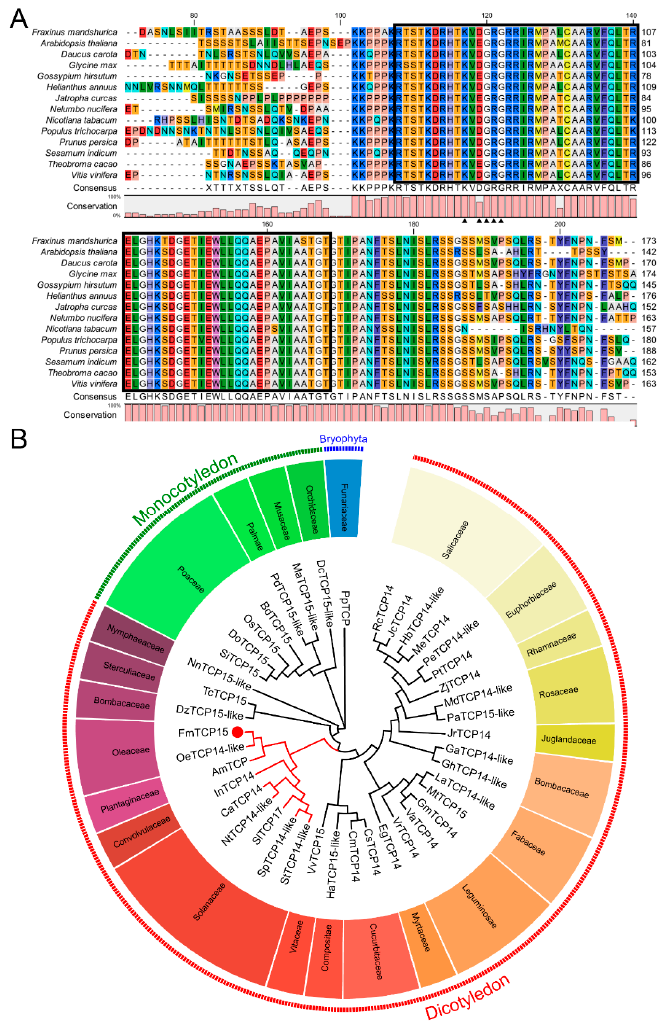
Figure 2. Multiple sequence alignment and phylogenetic relationship of FmTCP15 protein. ( A ) Homolog alignment of FmTCP15 protein. The colored bars at the bottom represent the conservation percentage. The black box and black triangle represent the TCP conserved domain and five ligand binding sites, respectively. ( B ) Phylogenetic relationship of FmTCP15 proteins. The phylogram of FmTCP15 proteins is presented in circle mode (displays only topology). The phylogenetic tree was constructed using the neighbor-joining method with MEGA 5.0 software (Oxford University Press: New York, NY, USA). FmTCP15 is denoted by a red dot. FmTCP15 ( Fraxinus mandshurica ), DzTCP15-like ( Durio zibethinus ), HaTCP15-like ( Helianthus annuus ), InTCP14 ( Ipomoea nil ), CmTCP14 ( Cucumis melo ), CsTCP14 ( Cucumis sativus ), RcTCP14 ( Ricinus communis ), HbTCP14-like ( Hevea brasiliensis ), JcTCP14 ( Jatropha curcas ), MeTCP14 ( Manihot esculenta ), LaTCP14-like ( Lupinus angustifolius ), MtTCP15 ( Medicago truncatula ), PpTCP ( Physcomitrella patens ), JrTCP14 ( Juglans regia ), GmTCP14